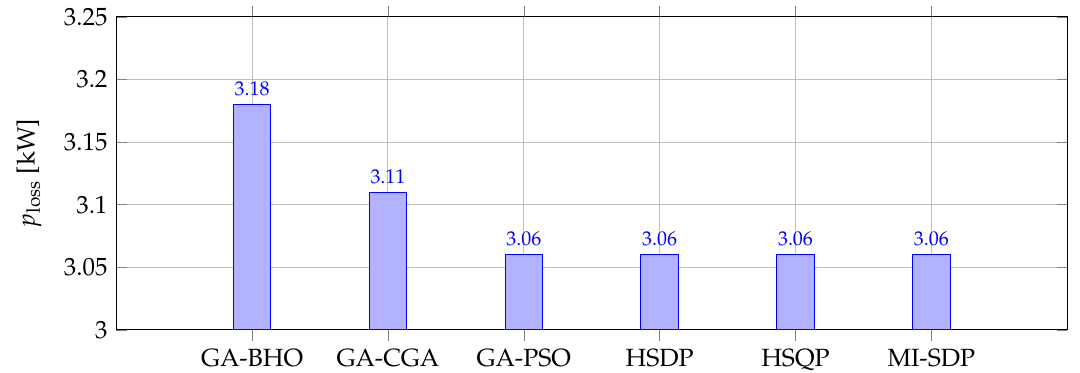
Figure 6. Final power losses when heuristics and metaheuristics are compared to the MI-SDP